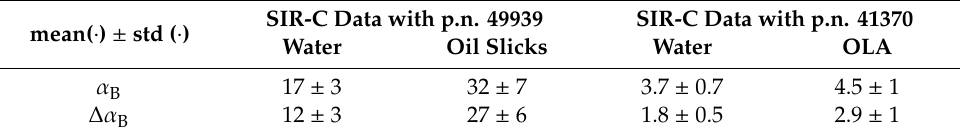
Table 2. α B and ∆ α B values (in degrees) of the FP images for the outlined areas in Figure